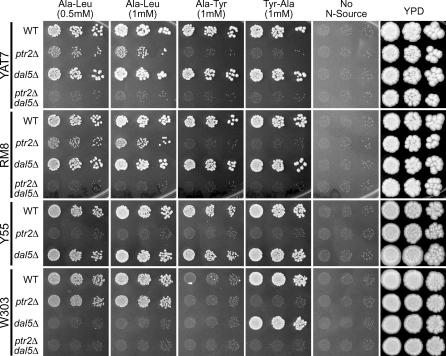
The Relative Contributions of Dal5p and Ptr2p to Dipeptide Utilization Vary among Strains of S. cerevisiae
Strains were cultured on YPD plates, as with the PM assays, and then suspended in water at a concentration of approximately 3.5 × 106 cells/ml and plated as 1×, 5×, and 25× dilutions (from left to right). Each plate contained MM plus the nitrogen source indicated at the top of the column (with the exception of the far right column, in which YPD plates were used). Plates were incubated at 30 °C for 4 d and then photographed. A Y55-ptr2Δdal5Δ double mutant was not tested, since deletion of PTR2 alone was sufficient to eliminate dipeptide utilization.